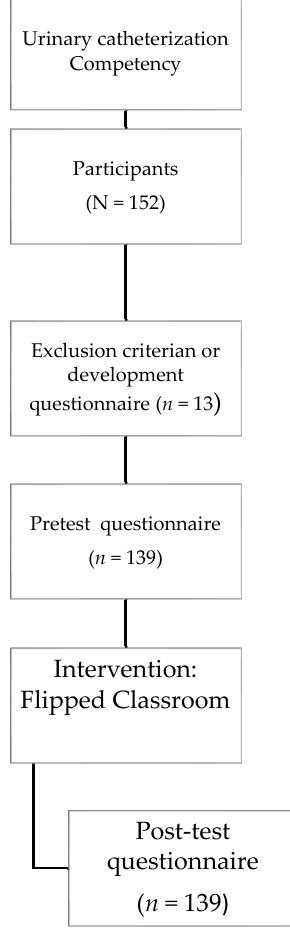
Figure 1. Flow diagram of participants.